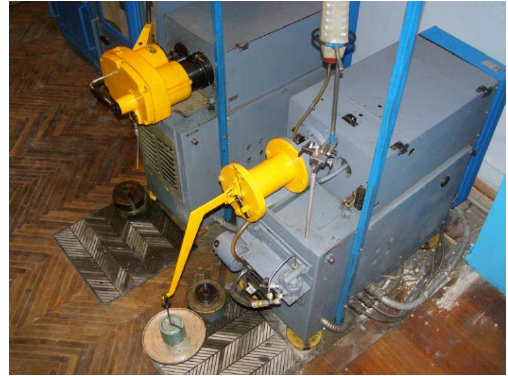
Fig. 1. Experimental equipment based on the friction machine